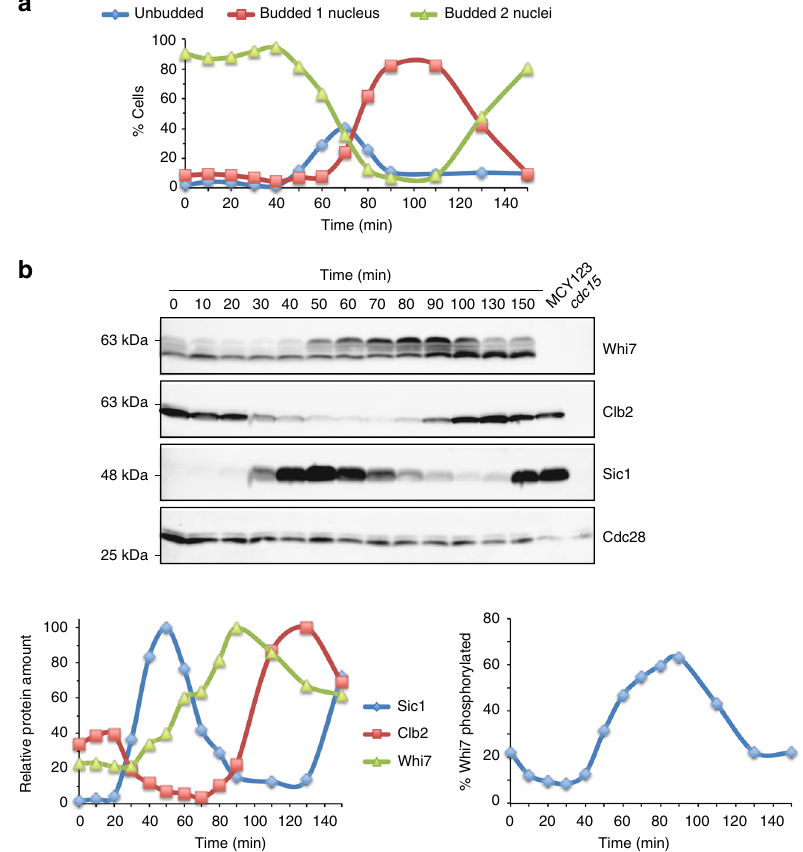
Fig. 1 Cell cycle regulation of Whi7. cdc15 cells expressing GFP-tagged Whi7, HA-tagged Clb2, and myc-tagged Sic1 (JCY1802) were arrested in telophase by incubation at 37 °C. After 3 h, cells were transferred to 25 °C and cell cycle progression was analyzed at the indicated time. a Graph shows the distribution of cells at different cell cycle stages. b Whi7, Clb2, and Sic1 proteins, as well as Cdc28 as loading control, were analyzed by western blot; left graph shows the relative amount of each protein referred to the most abundant sample; right graph represents the percent of total Whi7 protein present as slow migrating bands. MCY123 and no tagged cdc15 strains were included in western analysis as